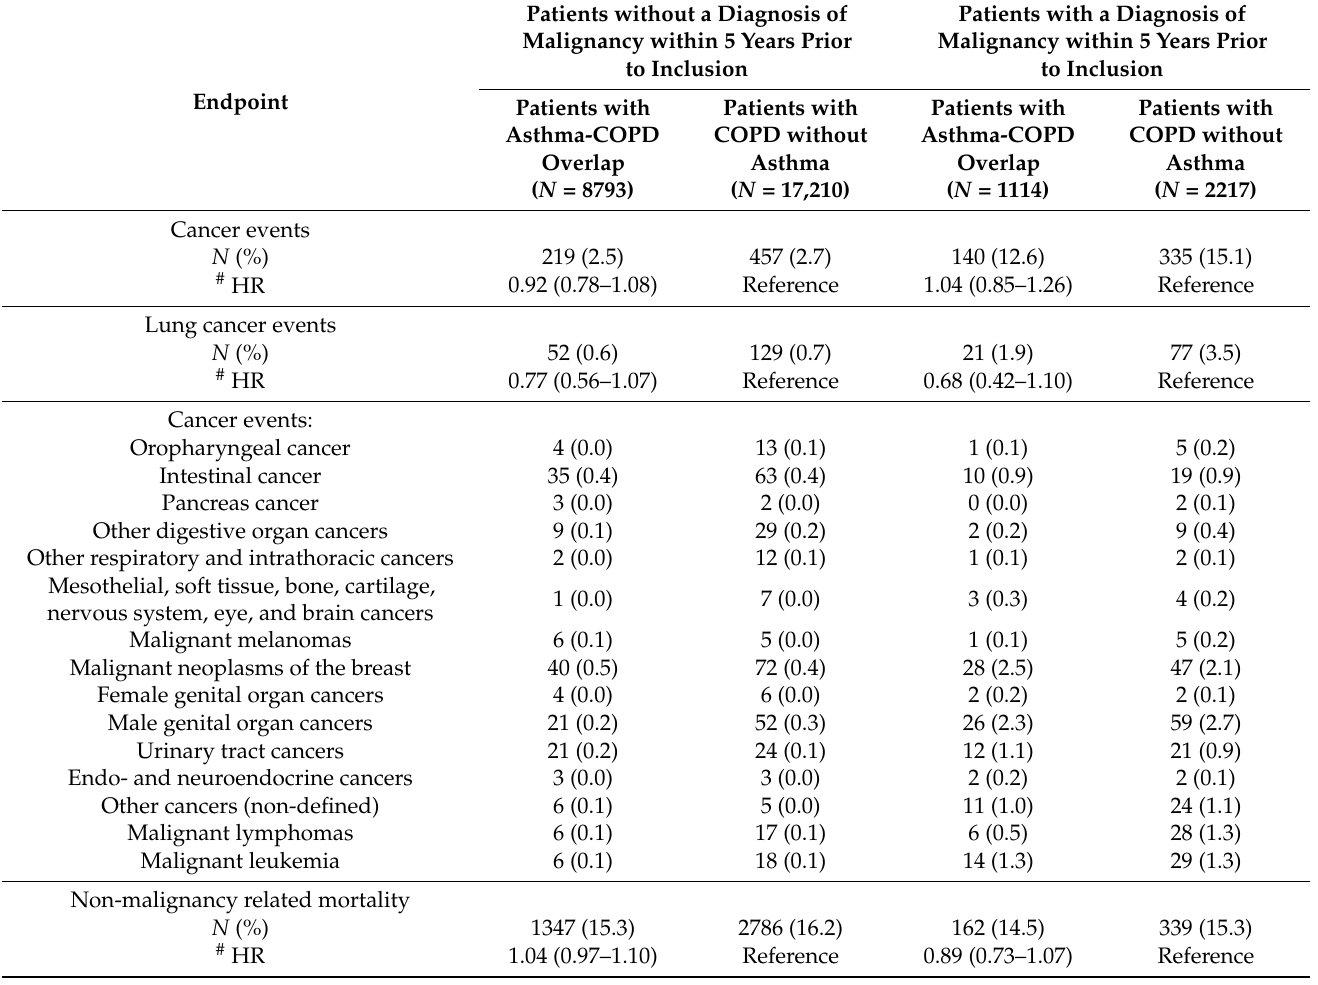
Table 2. Cancer events in propensity-matched groups of patients with asthma-COPD overlap and groups of patients with COPD without asthma.